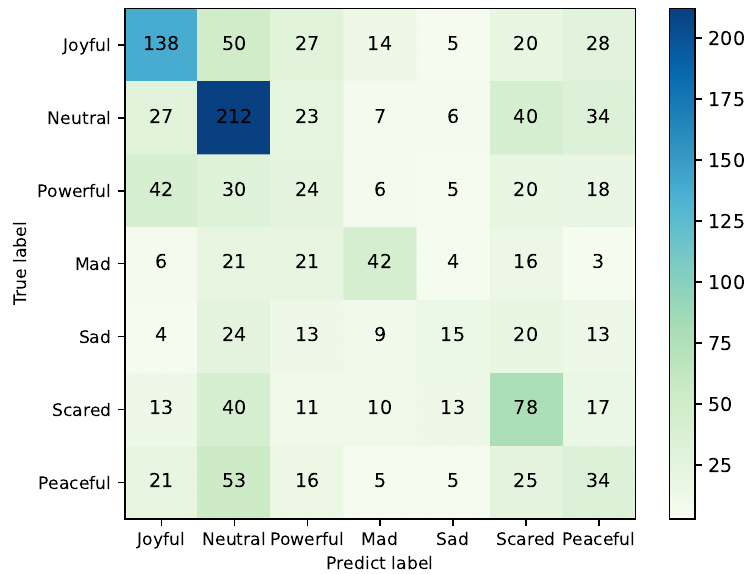
Figure 5. Heatmap of the confusion matrix of ERMC-MHGNN on the EmoryNLP dataset. We also studied the emotional shift issue, which means that the emotions of two consecutive utterances from the same speaker were different. Since DialogXL did not pro- vide the corresponding emotional shift prediction accuracy on the MELD and EmoryNLP datasets, we reproduced it. The weighted-average F1 of DialogXL on the MELD and EmoryNLP datasets was 62.67% and 35.0%, respectively, which are both higher than the results in the paper. The emotional shift prediction accuracy of DialogXL on the MELD and EmoryNLP datasets is listed in Table 5. It can be seen in Table 5 that, compared with the